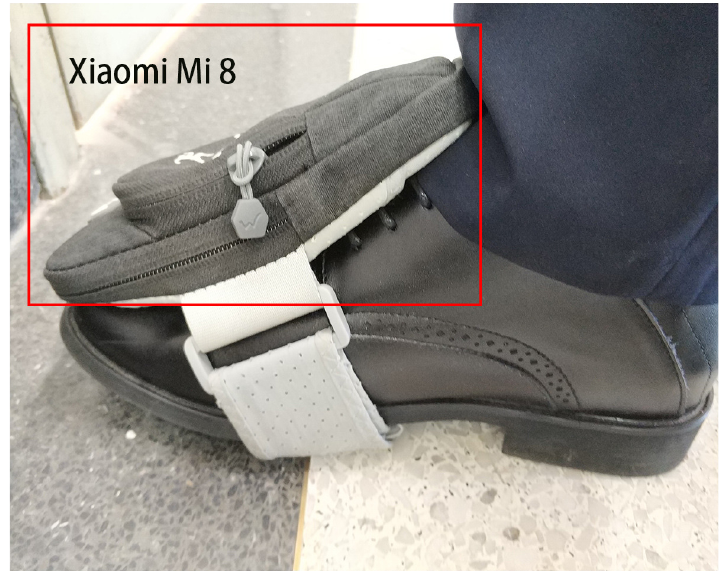
Figure 3. Close-up of tying the Xiaomi Mi 8 to our